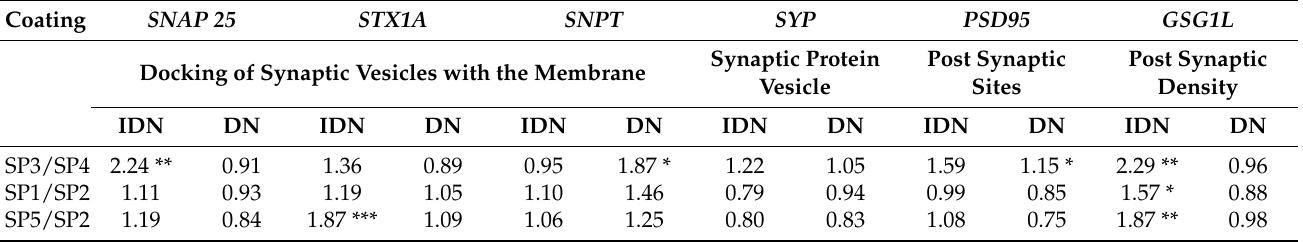
Table 5. Effect of various BAPs present in CCs on the expression of synapse-specific genes in human IDNs and DNs.